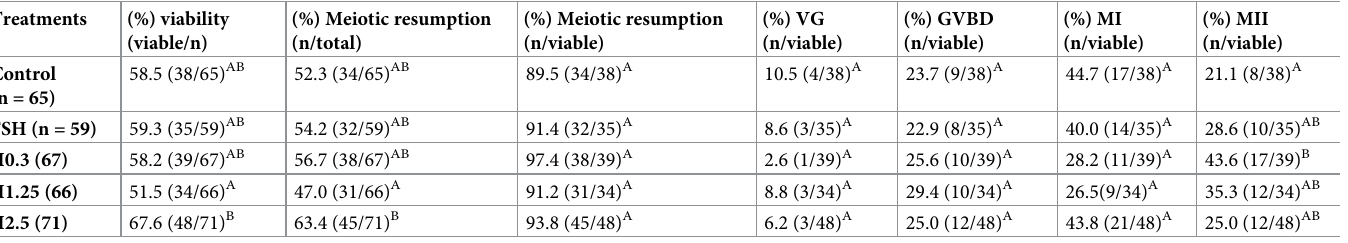
Table 7. Percentage of oocyte viability, meiotic resumption, and meiotic stages of oocytes recovery from antral follicles matured in TCM 199 (Control), FSH or in J . insularis 0.3, 1.25 or 2.5 mg/mL (JI0.3, JI1.25 or JI2.5